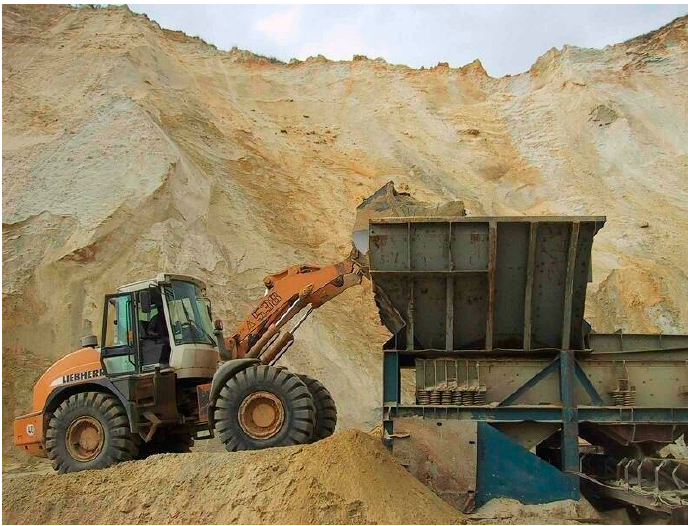
Figure 2. Gold tailings dam, Johannesburg, South Africa. Credit: EXTRACTEX, 2016. Source: http://www.extrac-tec.com/wp-content/gallery/mining-application/4gold-tailings_sa02.jpg (accessed on 26 March 2016).